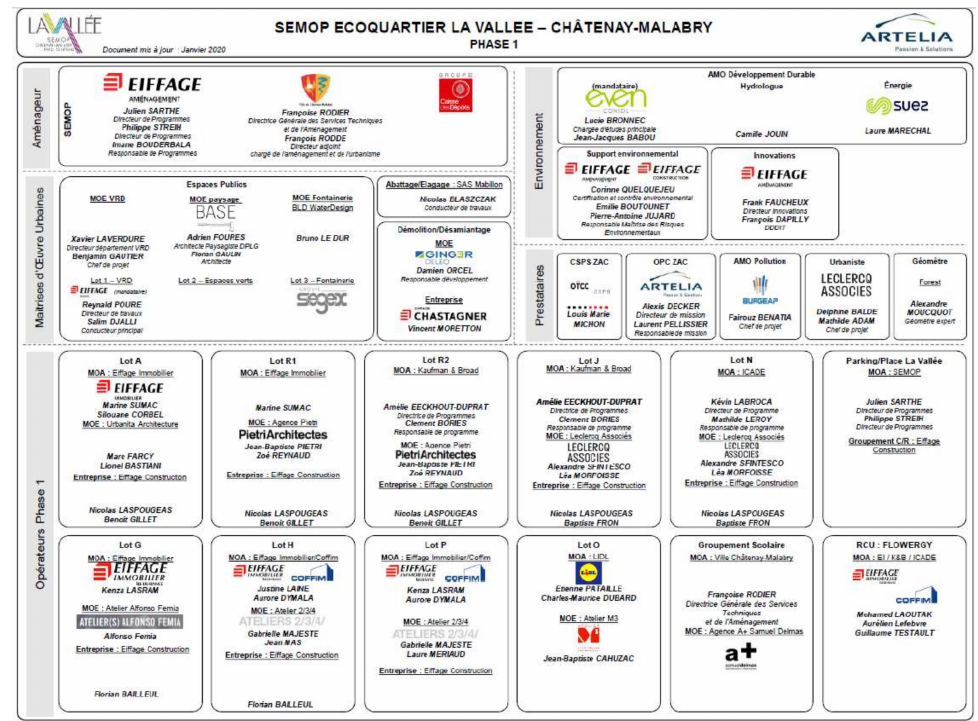
Figure 7. AEC partners of project for Phase 1. The real estate project is divided into: planners, urban project management, service providers, and environment and landscape